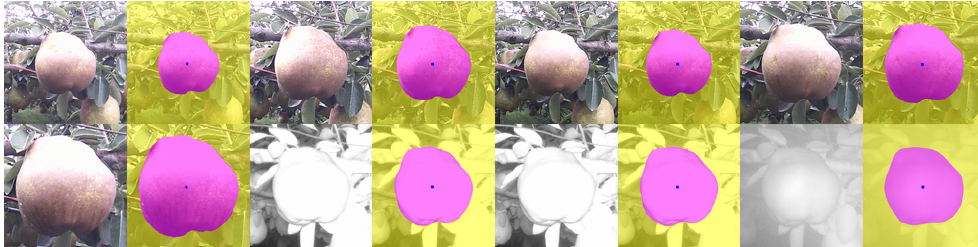
Figure 15. The eight images on 12 October 2020, the last day in Figure 14, whose image IDs are 487 to 494. These masks gave the medians appearing as part of the graph in Figure 13 and in Figure 14. Additionally, the blue dots describe the relative positions, which constitute part of the dots in Figure